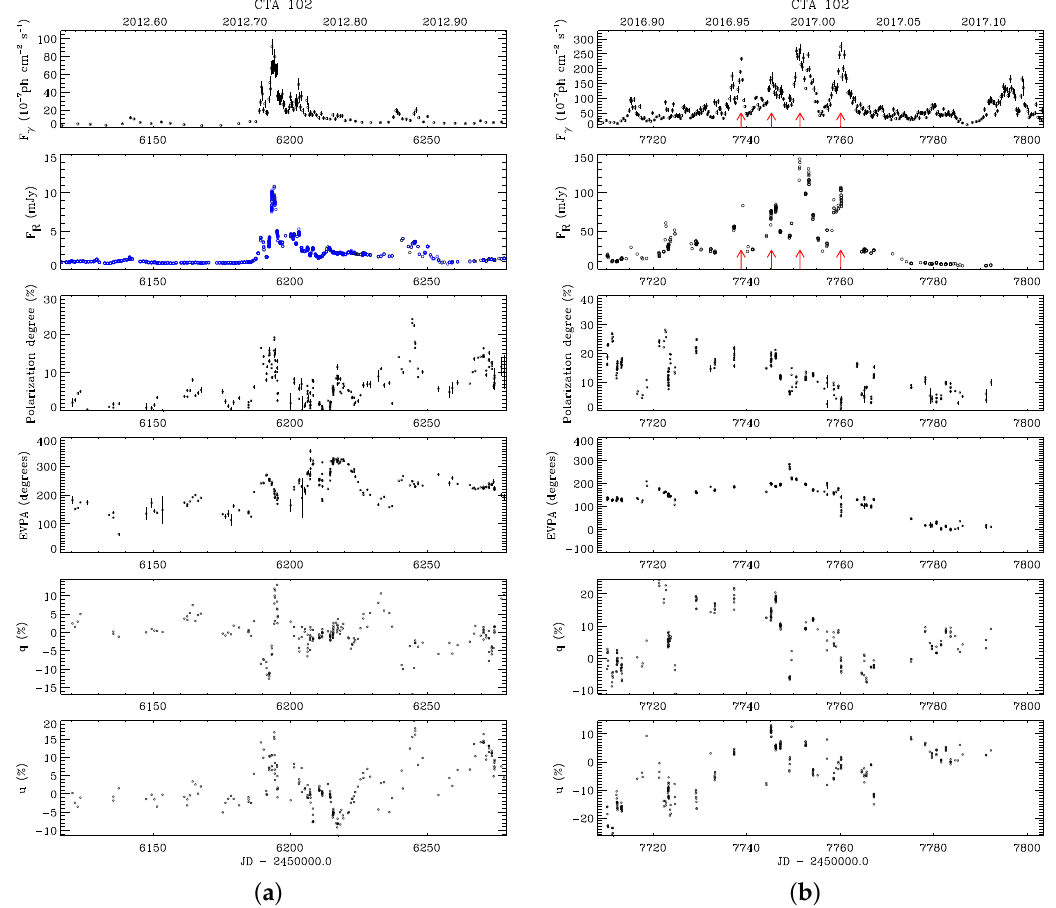
Figure 1. ( a ) From top to bottom: γ -ray flux evolution; optical R-band flux evolution, optical fractional polarization, position angle of polarization, and normalized Stokes parameters for CTA 102